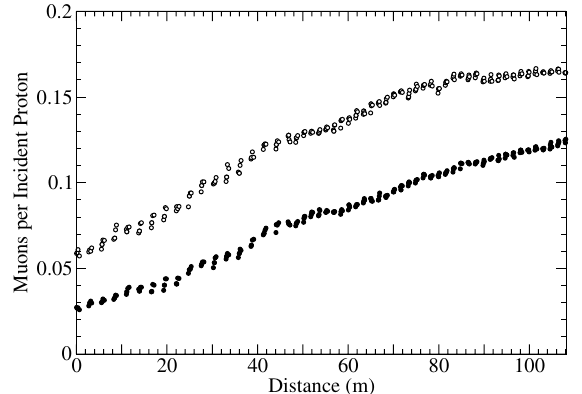
FIG. 20. Muons per incident proton in the cooling channel that would fall within a normalized transverse acceptance of 15 mm (open circles) or 9.75 mm (filled